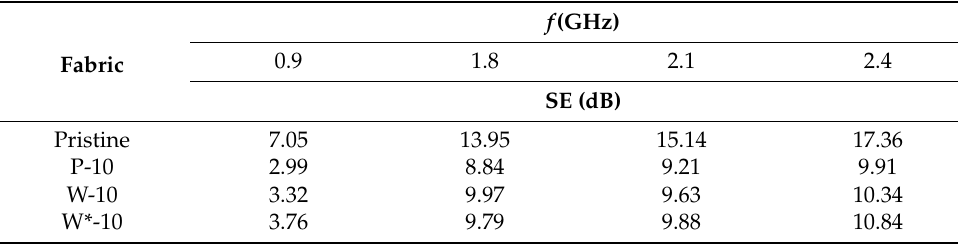
Table 6. Shield effectiveness of PES/CO/SS fabric (back side) before and after 10 cycles of professional care (P-10, W-10, W*-10) at the frequencies 0.9 GHz, 1.8 GHz, 2.1 GHz, and 2.4 GHz. f (GHz) 249 0.9 Fabric Table 6 . Shield effectiveness of PES/CO/SS fabric (back side) before and after 10 cycles of profes- 250 Table 6 . Shield effectiveness of PES/CO/SS fabric (back side) before and after 10 cycles of profes- Table 6 . Shield effectiveness of PES/CO/SS fabric (back side) before and after 10 cycles of profes- 250 Table 6 . Shield effectiveness of PES/CO/SS fabric (back side) before and after 10 cycles of profes- 250 251 Table 6 . Shield effectiveness of PES/CO/SS fabric (back side) before and after 10 cycles of profes- 250 Table 6 . Shield effectiveness of PES/CO/SS fabric (back side) before and after 10 cycles of profes- Table 6 . Shield effectiveness of PES/CO/SS fabric (back side) before and after 10 cycles of profes- 250 sional care (P-10, W-10, W*-10) at the frequencies 0.9 GHz, 1.8 GHz, 2.1 GHz, and 2.4 GHz . sional care (P-10, W-10, W*-10) at the frequencies 0.9 GHz, 1.8 GHz, 2.1 GHz, and 2.4 GHz . sional care (P-10, W-10, W*-10) at the frequencies 0.9 GHz, 1.8 GHz, 2.1 GHz, and 2.4 GHz . sional care (P-10, W-10, W*-10) at the frequencies 0.9 GHz, 1.8 GHz, 2.1 GHz, and 2.4 GHz . 251 sional care (P-10, W-10, W*-10) at the frequencies 0.9 GHz, 1.8 GHz, 2.1 GHz, and 2.4 GHz . 251 sional care (P-10, W-10, W*-10) at the frequencies 0.9 GHz, 1.8 GHz, 2.1 GHz, and 2.4 GHz . sional care (P-10, W-10, W*-10) at the frequencies 0.9 GHz, 1.8 GHz, 2.1 GHz, and 2.4 GHz . 251 Pristine Fabric Fabric Pristine